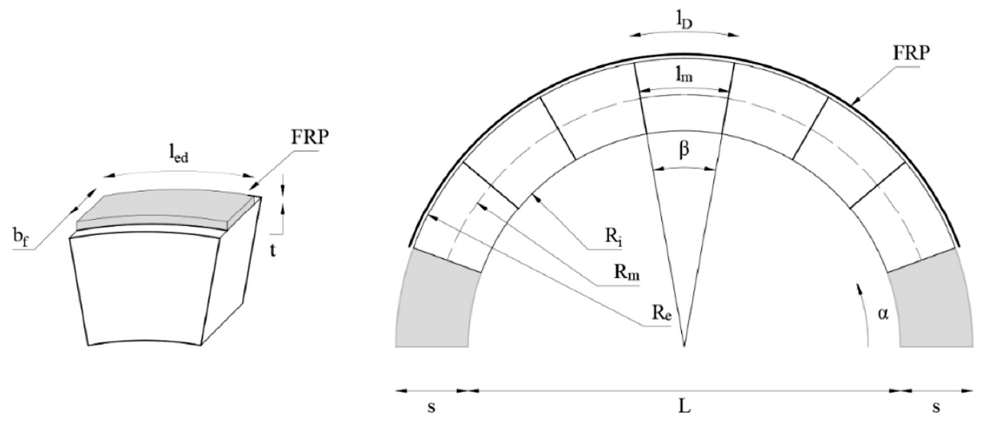
Figure 5. Nomenclature of the Hinged Lifting Arch (HLA). Appl. Sci. 2020 , 10 , x FOR PEER REVIEW